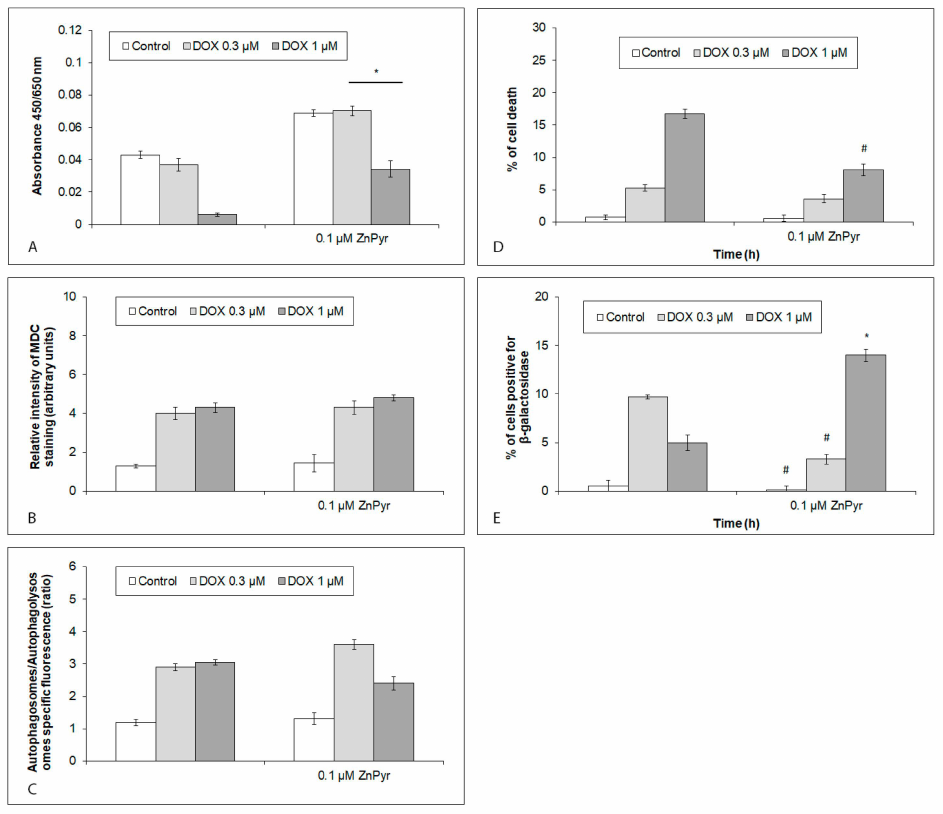
Figure 6. Effects of enhanced intracellular free Zn levels on viability and cell phenotypes in hiPCS- CMs exposed to 0.3 µ M and 1 µ M DOX at 120 h. Cardiomyocytes were treated with 0.1 µ M zinc pyrthione (ZnPyr) alone or together with 0.3 µ M and 1 µ M DOX concentrations, and their ( A ) viability, ( B , C ) autophagy, ( D ) cell death, and ( E ) senescence were measured by particular assays (Section 4). Values represent means ± SD of N = 3 (viability), N = 4 (autophagy), N = 3 (cell death), and N = 3 (senescence) experiments. #,* p < 0.05 compared to untreated cells with enhanced free Zn content at the same treatment interval with one-way ANOVA test and Dunnett’s post test for multiple